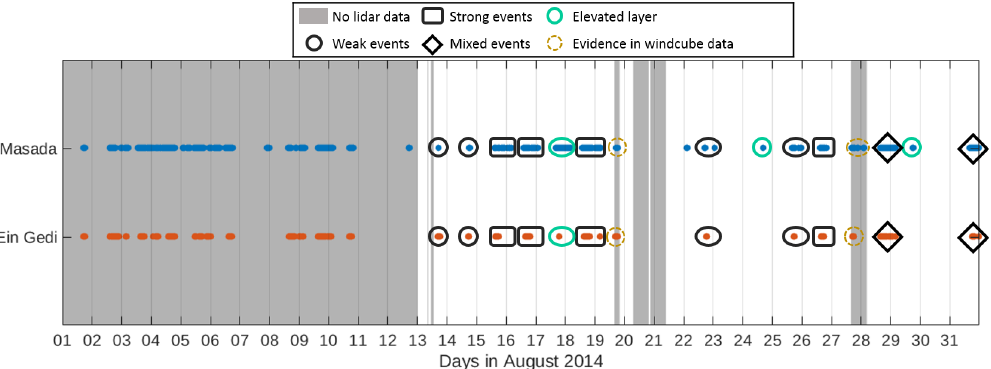
Figure 4. Occurrence of foehn in August 2014 at the slope (Masada, blue dots) and in the valley (Ein Gedi, red dots). Shown is the foehn occurrence with a detection probability of more than 75%. Grey shaded area shows the dates when lidar data were not